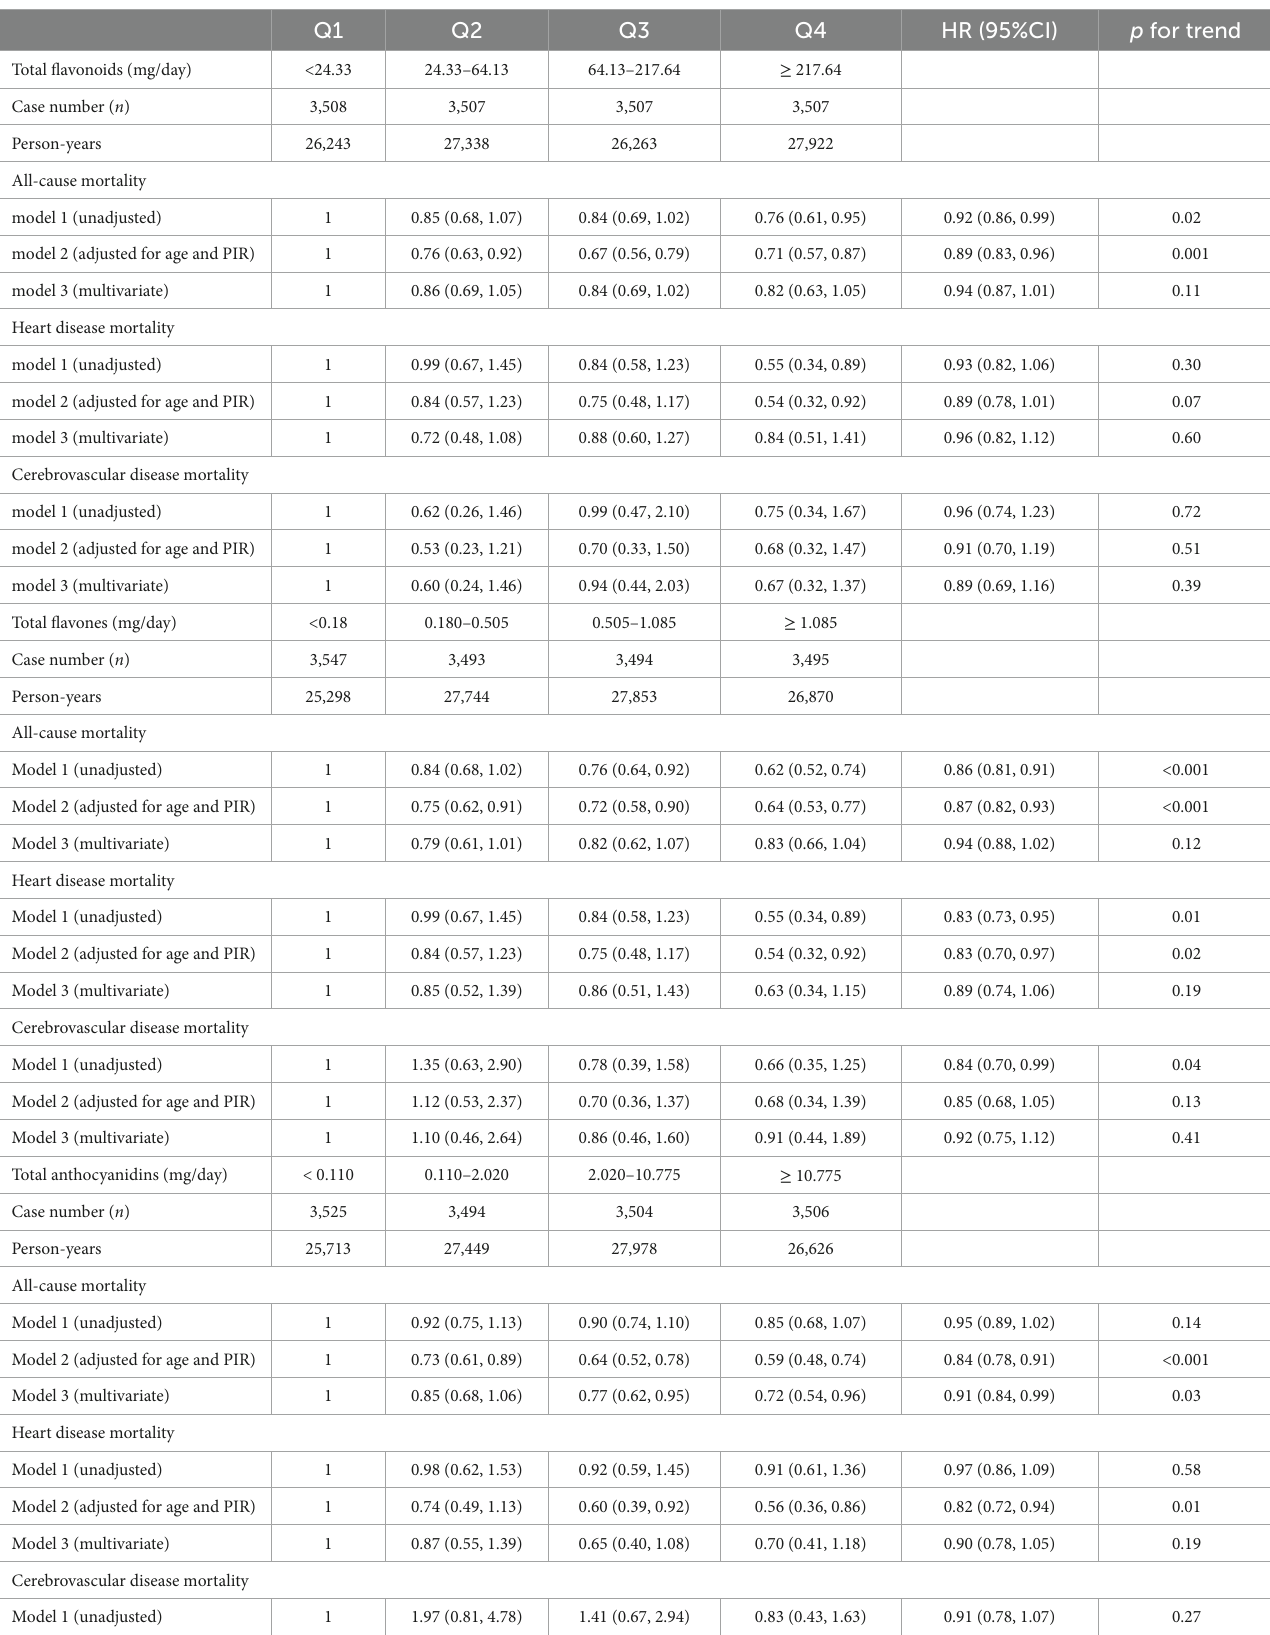
TABLE 3 Hazard ratios of mortality by quartiles of flavonoid intake. Q1 Q2 Q3 Q4 HR (95%CI) p for